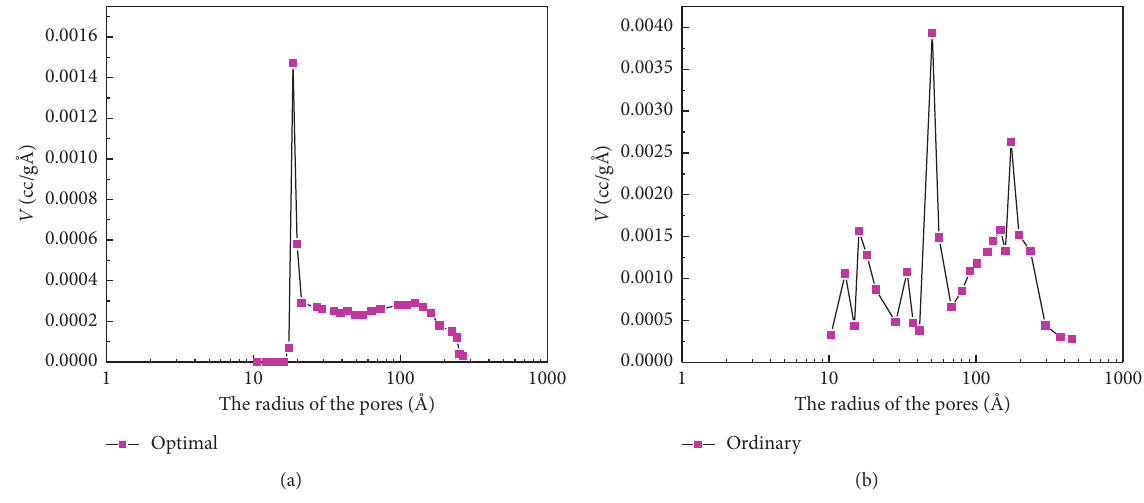
Figure 10: Desorption pore-volume distribution by the BJH